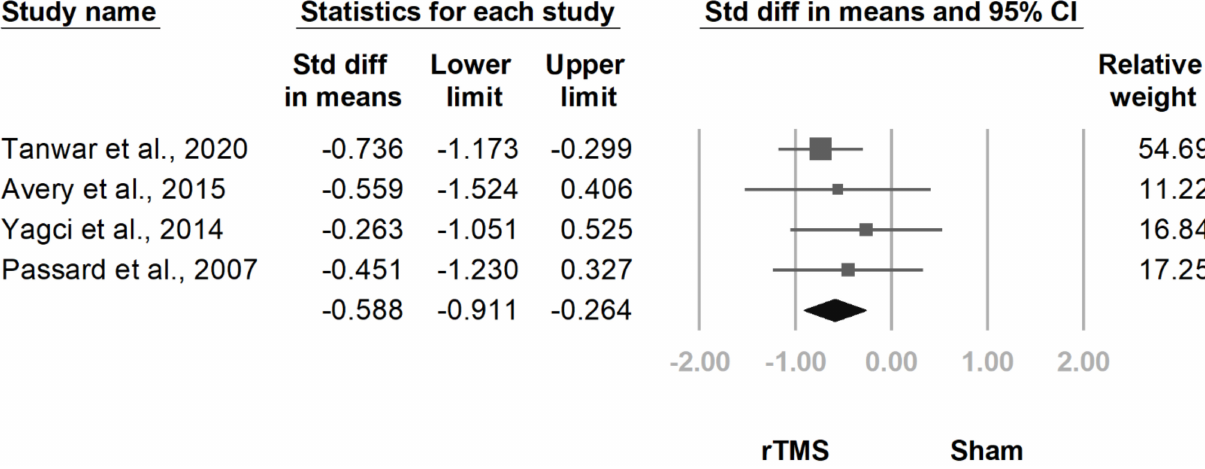
Figure 8. Forest plot of standardized mean differences in intensity of pain at follow-up at 1.5 to 3 months after last treatment session. Squares indicate effect sizes of individual studies, lines indicate 95% CI, and diamond indicates the summarized effect